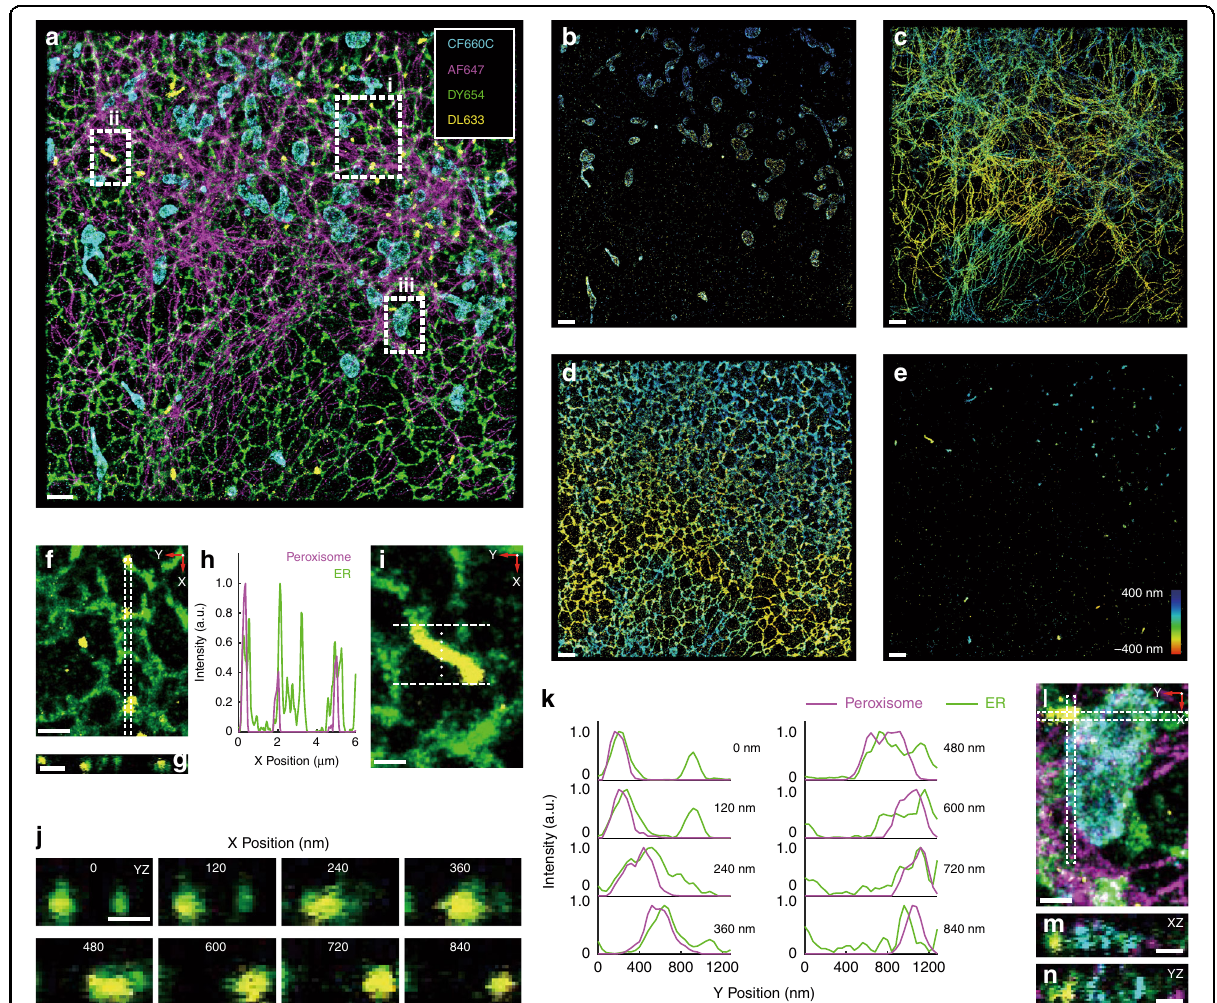
Fig. 5 3D Tetra-color imaging based on ExR-STORM. a-e CF660C, Alexa Fluor 647, Dyomics 654, and DyLight 633 were selected to label the outer mitochondrial membrane (cyan), intermediate fi laments (magenta), endoplasmic reticulum (green), and peroxisomes (yellow), respectively, in a fi xed COS-7 cell. a Reconstructed image of the four merged channels. b – e Color-coded four channels in ( a ). f – k Colocalization of peroxisomes and endoplasmic reticulum. f Zoomed-in view of boxed region i in ( a ). g XZ (120nm in Y) cross-section of the boxed region in ( f ). h Intensity pro fi le along the boxed region in ( f ). i Zoomed-in view of the boxed region ii in ( a ). j YZ (120 nm in X) cross-sections of the region between the two dashed lines in ( i ), where the distance between adjacent cross-sections in the X direction is 120 nm. k Intensity pro fi les along the Y direction in ( i ), with each pro fi le corresponding to the cross-section image in ( j ). l The ER – mitochondria – peroxisome tripartite contact site in the boxed region iii in ( a ). m , n XZ (120nm in Y) and YZ (120 nm in X) cross-sections of the boxed regions in ( l ). Scale bars: 2 μ m ( a – e ); 1 μ m ( f – g ); 500 nm ( i , j, l – n